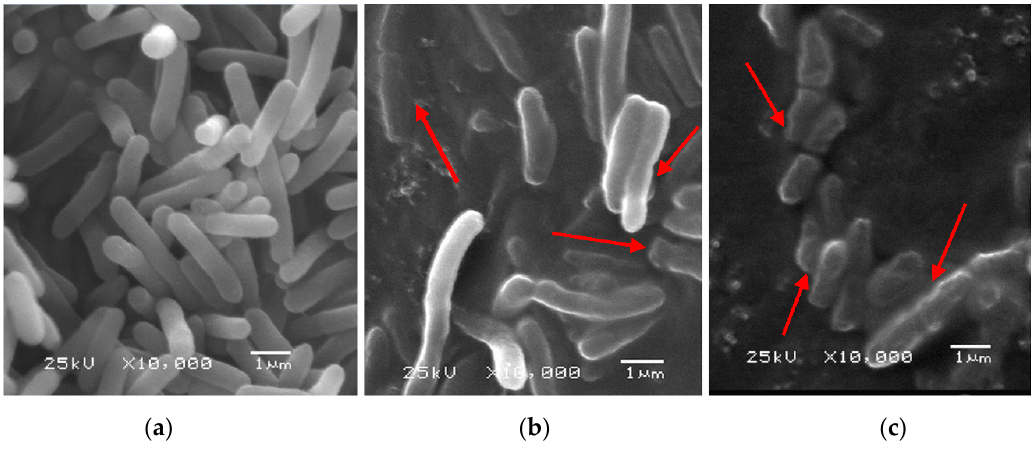
Figure 4. The effect of PEF treatment at 25 kV/cm with treatment time for 0, 1.6, and 4.0 ms on the morphology of S. typhimurium . ( a ) Control; ( b ) PEF-treated for 1.6 ms; and ( c ) PEF-treated for 4.0 ms. Arrows indicate the modifications of cell morphology and cell debris.